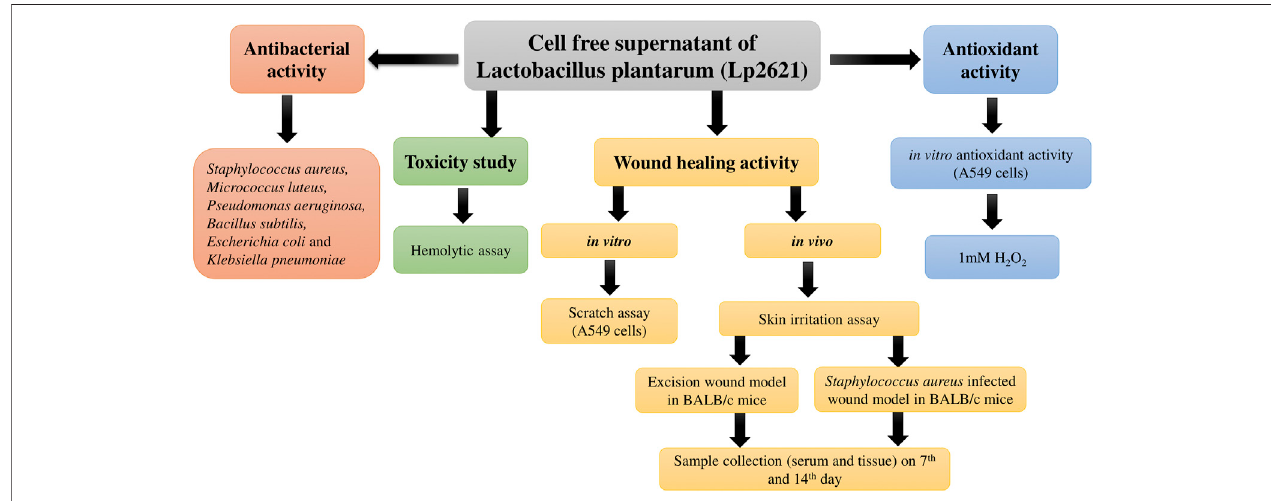
FIGURE 1 | Flowchart depicting the study design for evaluation of antibacterial, antioxidant, and wound healing potential of Lp2621.